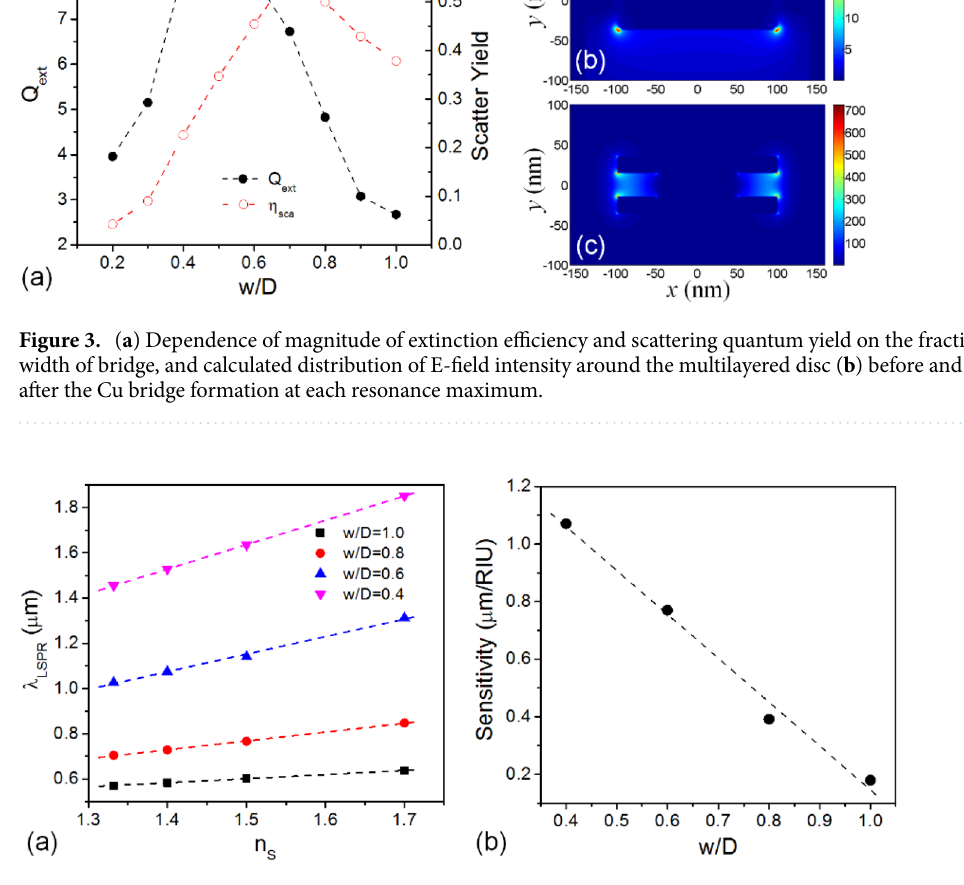
Figure 4. ( a ) Resonance wavelength of VCB nanodiscs with variable bridge widths as a function of the refractive index of surrounding medium and ( b ) the dependence of sensitivity of VCB nanodiscs on fractional bridge